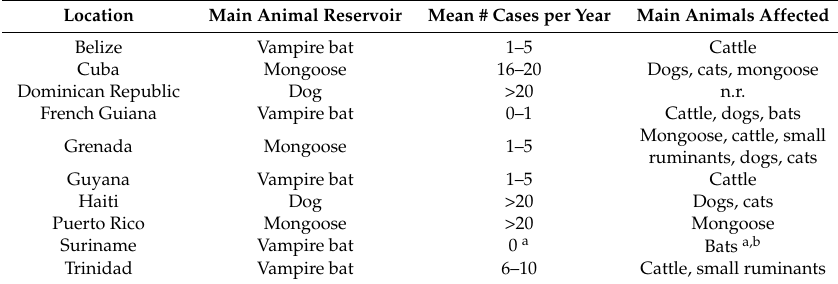
Table 1. Rabies endemic locations in the Caribbean: main animal reservoir and average case frequency with types of animals affected by country.